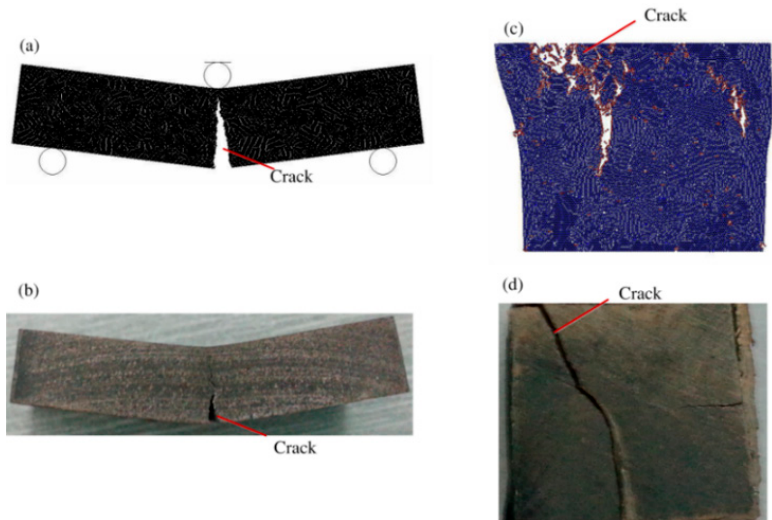
Figure 4. Failure of Co-based metal matrix after being tested: ( a , c ) by DEM simulation; ( b , d ) by experiment.